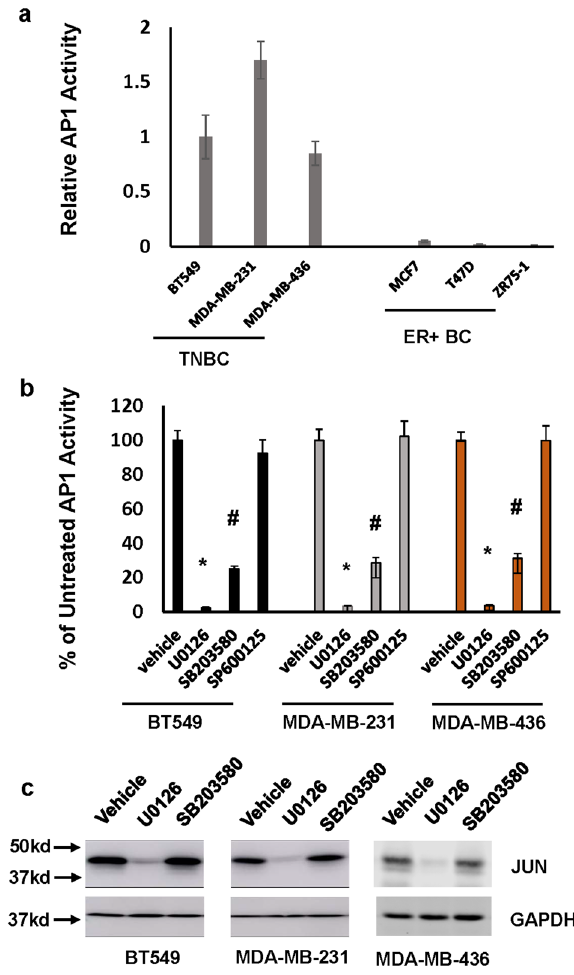
Fig. 1 Both ERK and p38 MAPK signaling pathways contribute to sustained AP1 activity in TNBC cells. a Endogenous AP1 activity in breast cancer cell lines analyzed by AP1 site-containing luciferase reporter plasmid. Data are means ± SD from three experiments. b BT549, MDA-MB-231, and MDA-MB-436 cells were treated with 5 µM U0126, SB203580, SP600125, or vehicle for 24 h followed by analyzing AP1 activity. Data are means ± SD from three experiments. * P < 0.001 vs vehicle; # P < 0.01 vs vehicle. c BT549, MDA-MB-231, and MDA-MB-436 cells were treated with 5 µM U0126, SB203580, or vehicle for 24 h followed by western analysis to detect JUN and GAPDH with the respective antibodies. Data are the representative of three independent experiments. All blots derived from the same experiment and were processed in